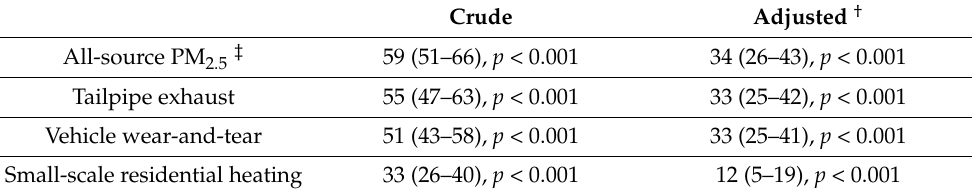
Table 2. Decrease and (95% confidence intervals) of birth weight (grams) associated with an in- terquartile range (IQR) * increase in exposure concentrations of the investigated local PM 2.5 sources during pregnancy.